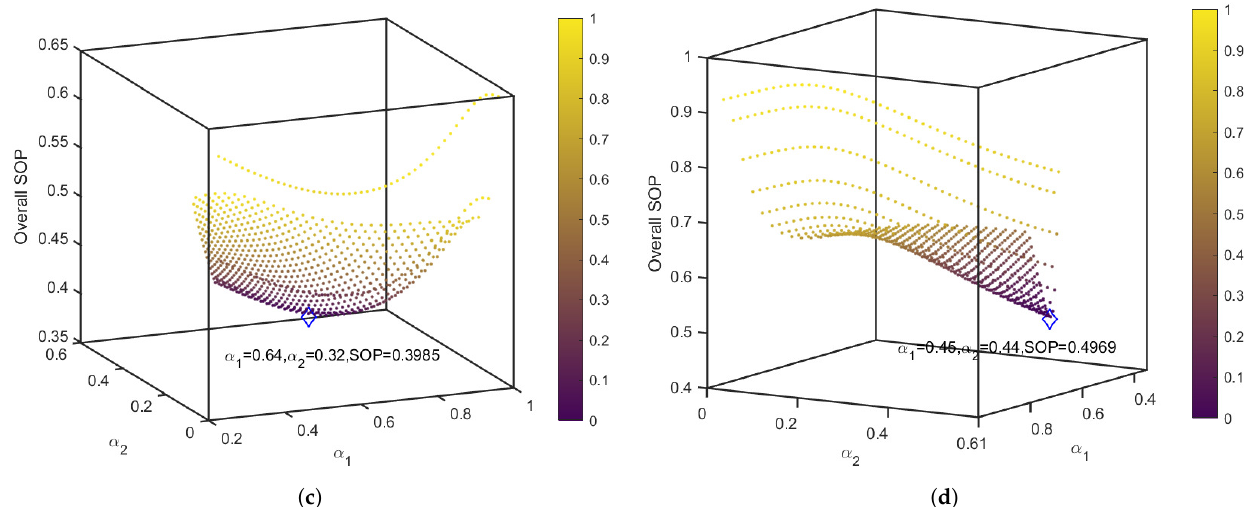
Figure 4. The SOPs of secondary users with various TAS schemes based on SA algorithm. ( a ) Overall SOP with max − U 1 of MCC scheme; ( b ) overall SOP with max − U 2 of MCC scheme; ( c ) overall SOP with max − U 3 of MCC scheme; and ( d ) overall SOP with ST scheme. Table 1. Optimal power allocation coefficients for different TAS schemes with different P t (in dBm).